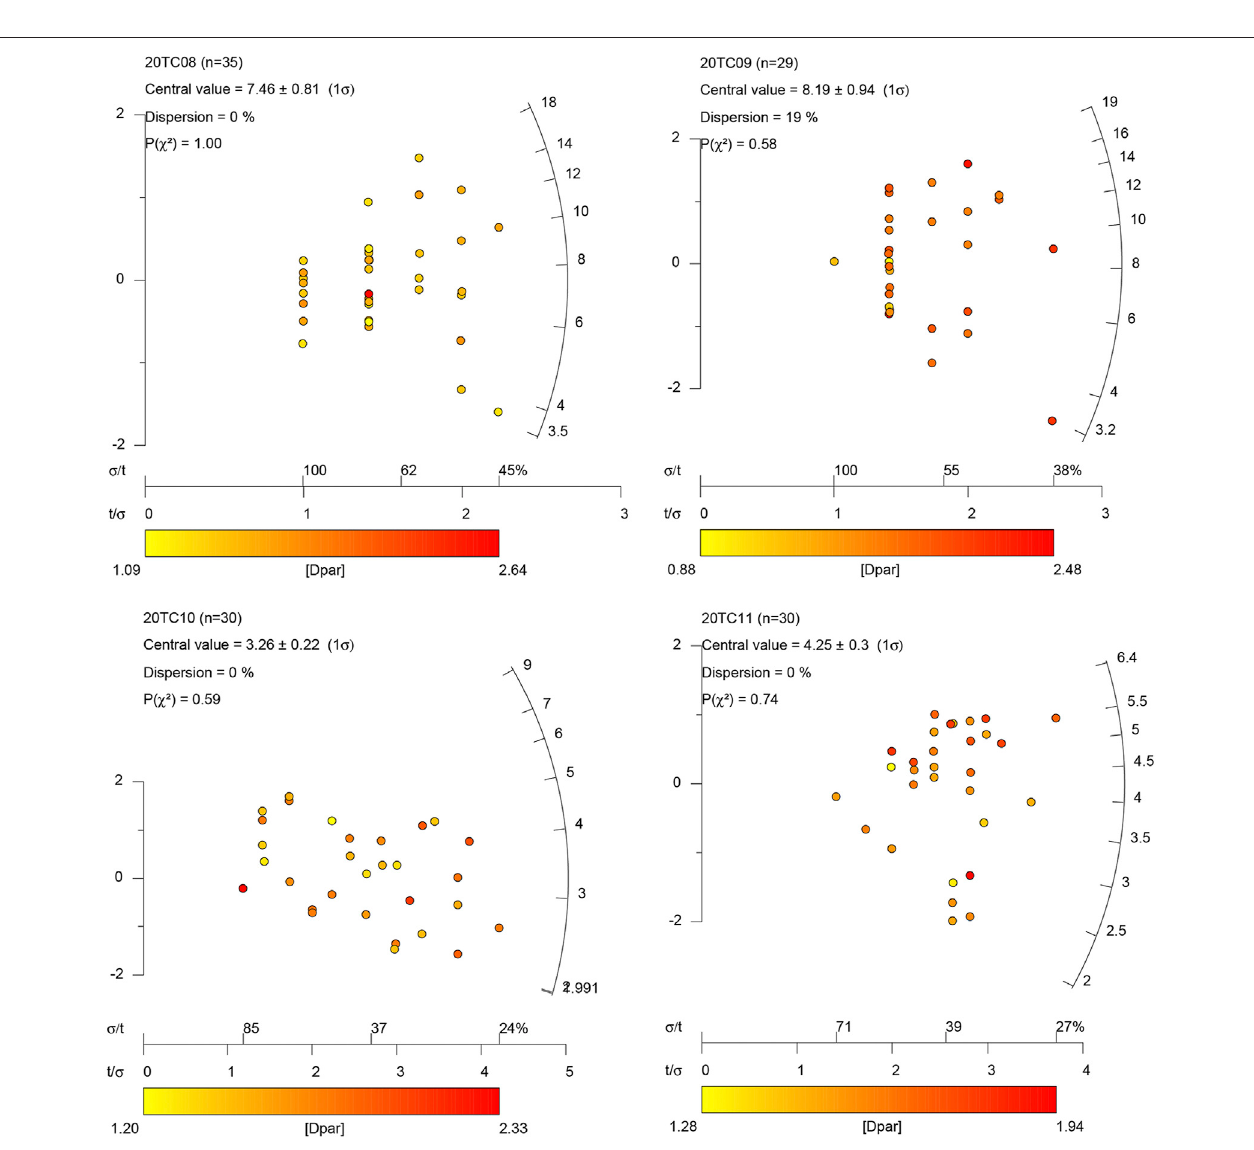
FIGURE 5 | Apatite fi ssion-track radial plots of study samples using Radial Plotter (Vermeesch, 2009). 20TC08 is sample number, Central value is median age of each sample, Dispersion is single grain dispersion, P( χ 2 ) is result of the chi-square test.